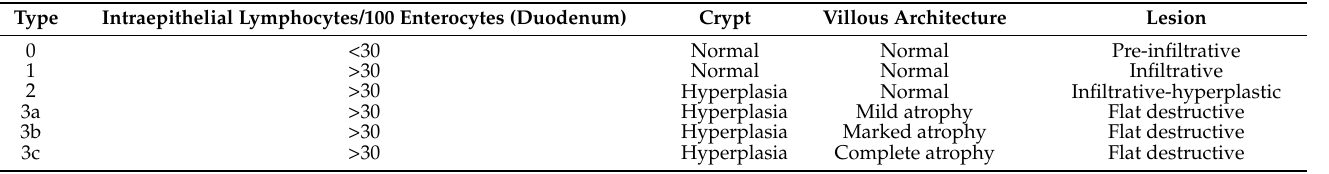
Table 1. Modified Marsh-Oberhuber classification